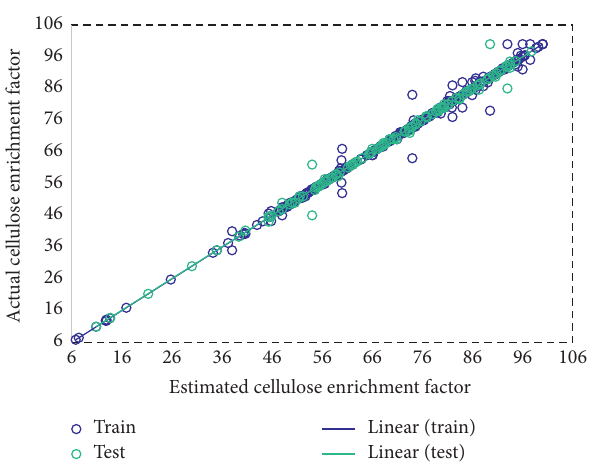
Figure 5: Cross plot on the CEF output values.